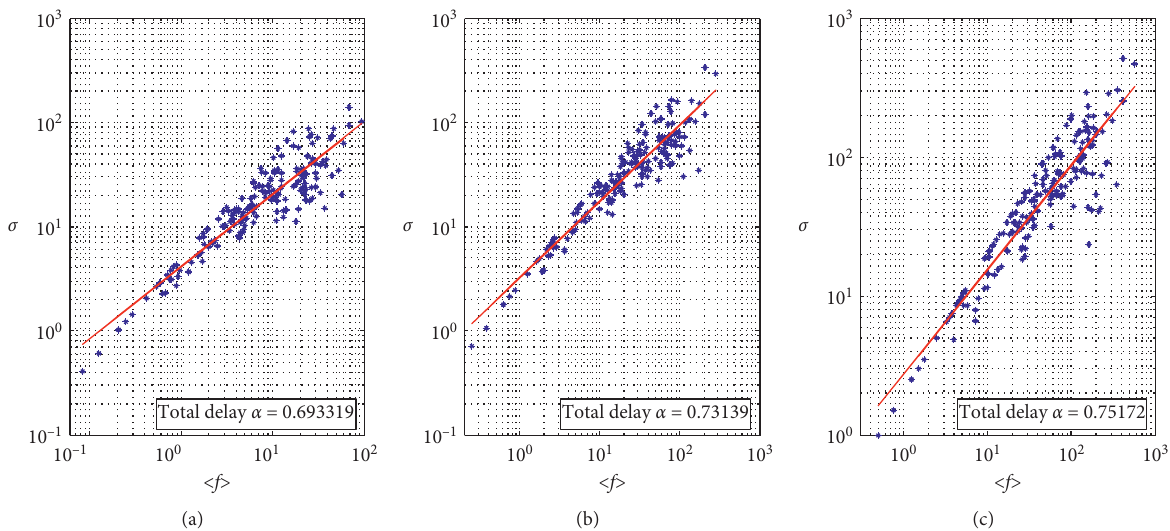
Figure 1: Scaling relations between fluctuations σ and AFD 〈 f 〉 at different time scales. (a) Δ t � 1h. (b) Δ t � 3h. (c) Δ t � 6h. The estimated values of scaling exponent α are also indicated.